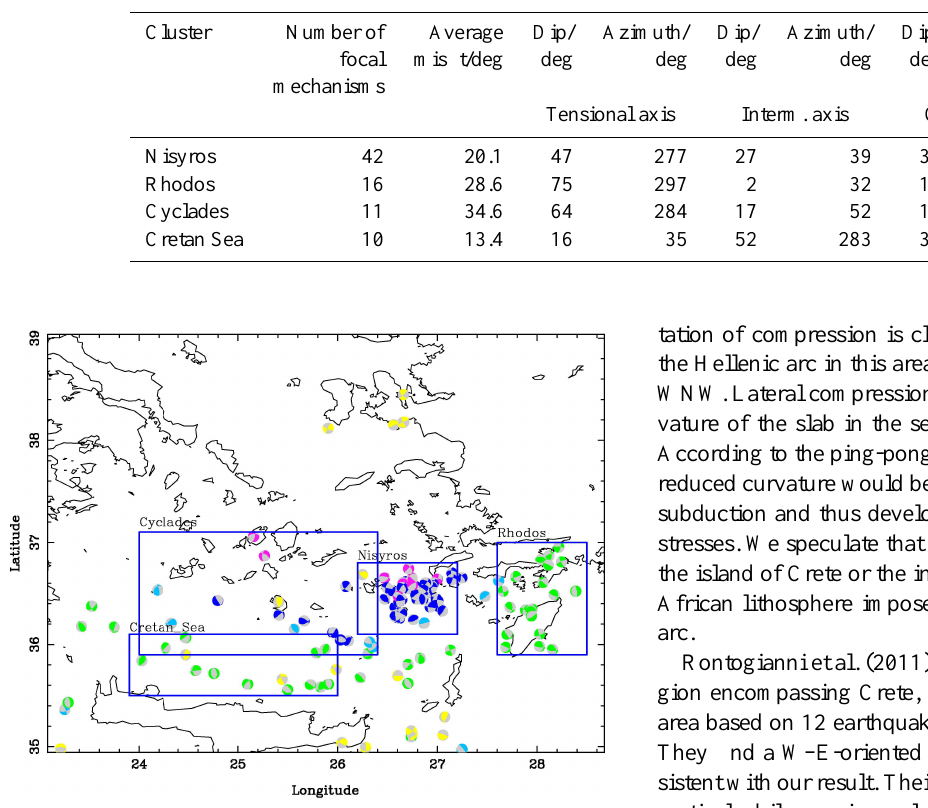
Fig. 14. Intermediate-depth earthquake locations with focal mechanisms and definition of cluster regions. The meaning of the colours of the beach balls are as given in Fig.